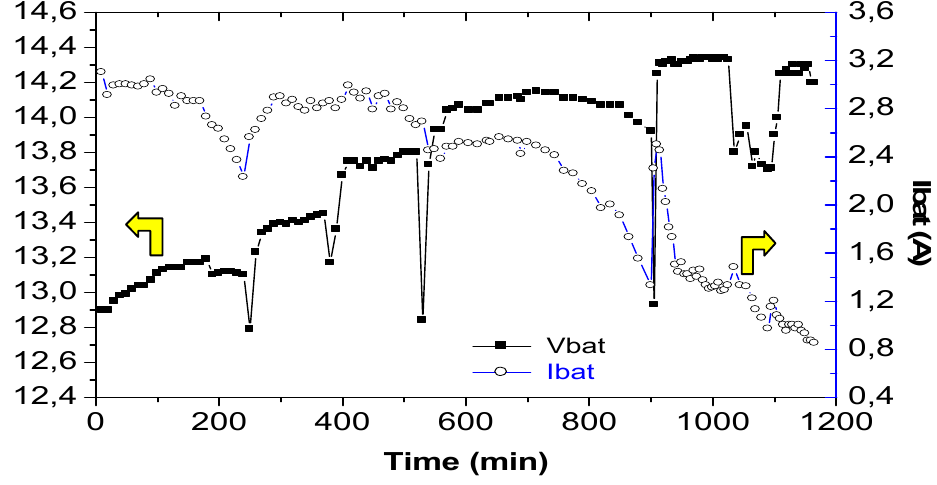
Figure 17. State of charge (SOC) of